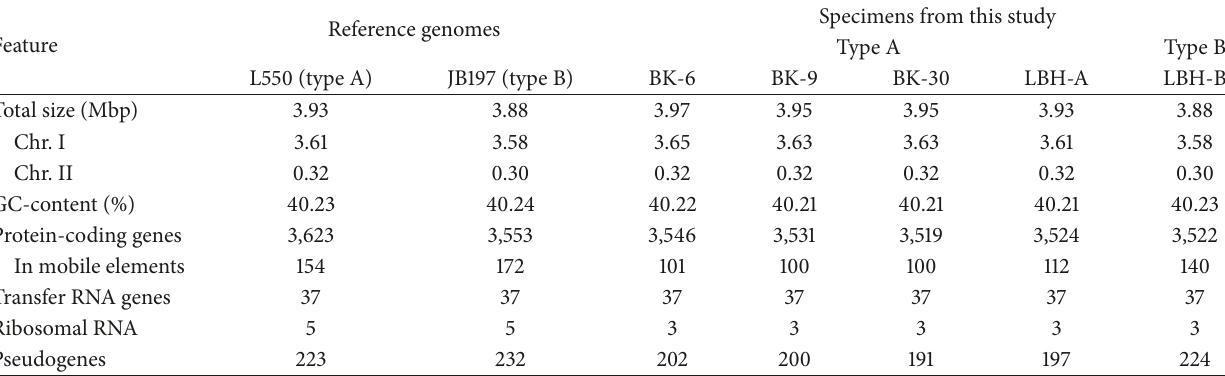
Table 1: Basic features of the five genomes sequenced in this study, compared to those of the reference genomes for L. borgpetersenii serovar Hardjo subtypes A and